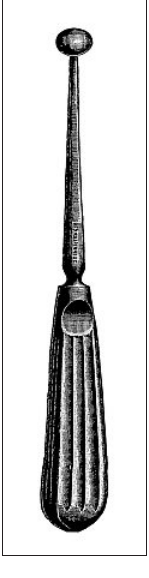
“Muck’s ball”.Tonsil-squeezer by Hartmann, from the main catalogue No. 33 of the Medicinisches Waarenhaus AG Berlin, ca. 1910, page 185 (reprint 1987,Th. Schaefer publishers, Hannover), which had to be curved according to the instructions of Dr O. Muck to its desired form [9] (Figure with kind permission ofTh. Schaefer publishers, Vincentz Network GmbH & Co. KG, Hannover,